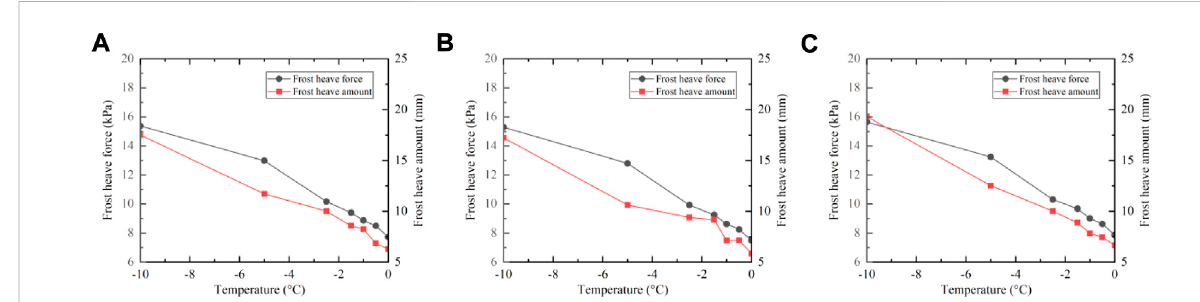
FIGURE 5 Change rules of frost heave force and amount in group C. (A) Section 1. (B) Section 2. (C) Section 3.